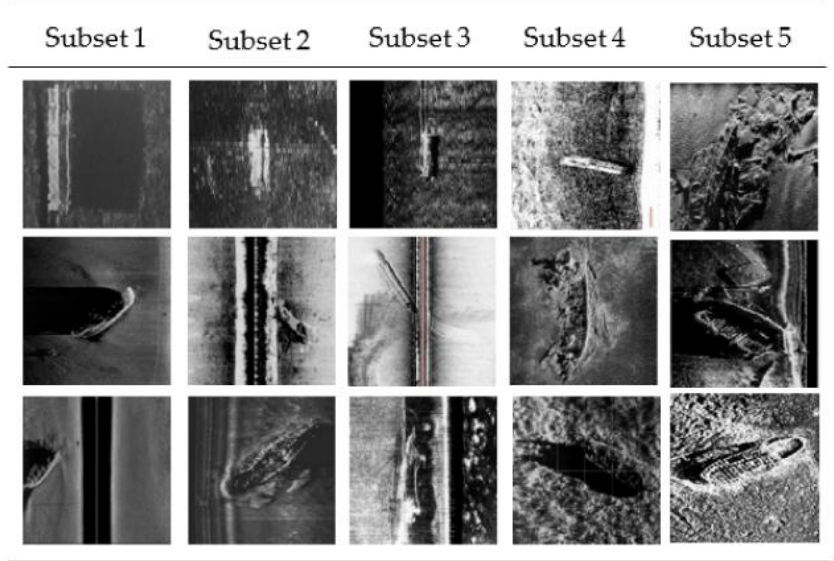
Figure 25. Some samples of 5 subsets divided from the test